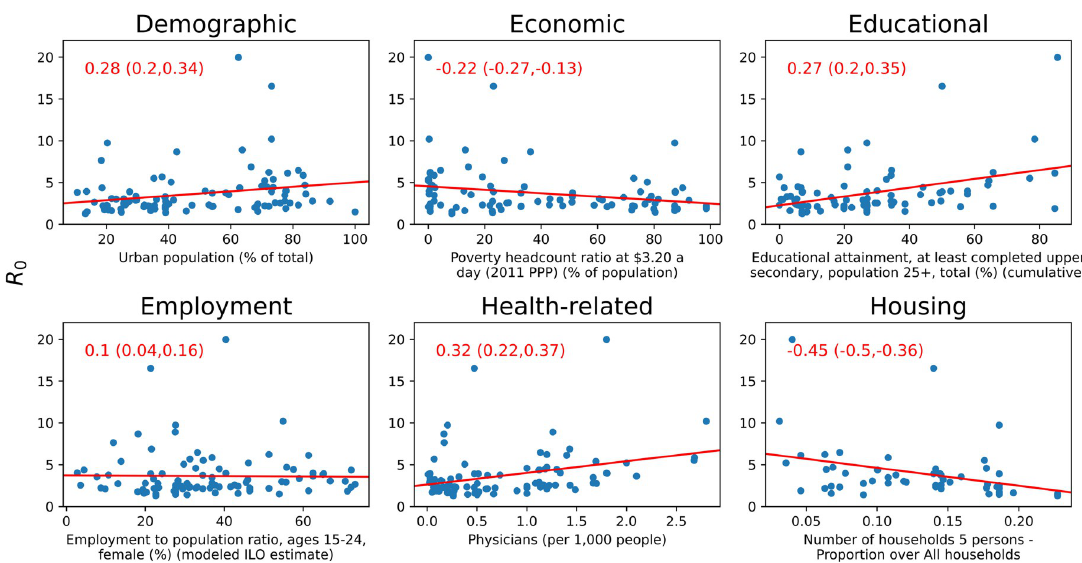
Fig 2. Indicators in each category with the largest Spearman correlation with R correlation regression line is plotted in